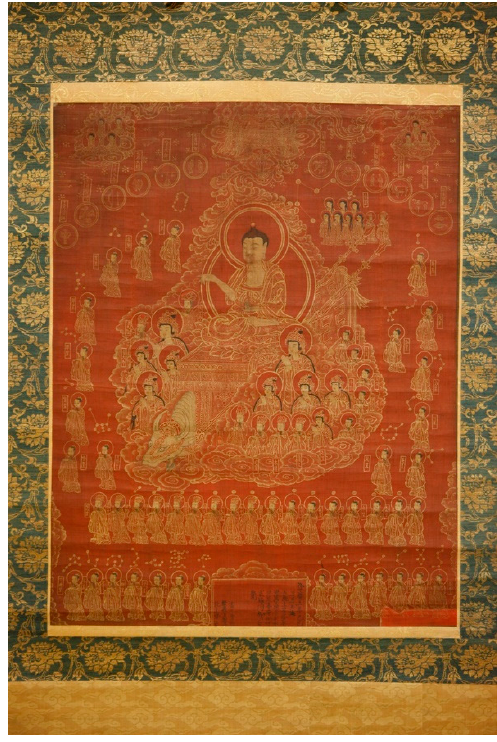
Figure 13. Descent of Tejaprabha Buddha (K. Chiseonggwang yeorae gangnimdo ), Joseon (1569), Ink and colors on hemp cloth, 84.8 × 66.1 cm, Korai Museum in Kyoto, Japan. Photo by Utaek Jeong in 2003.